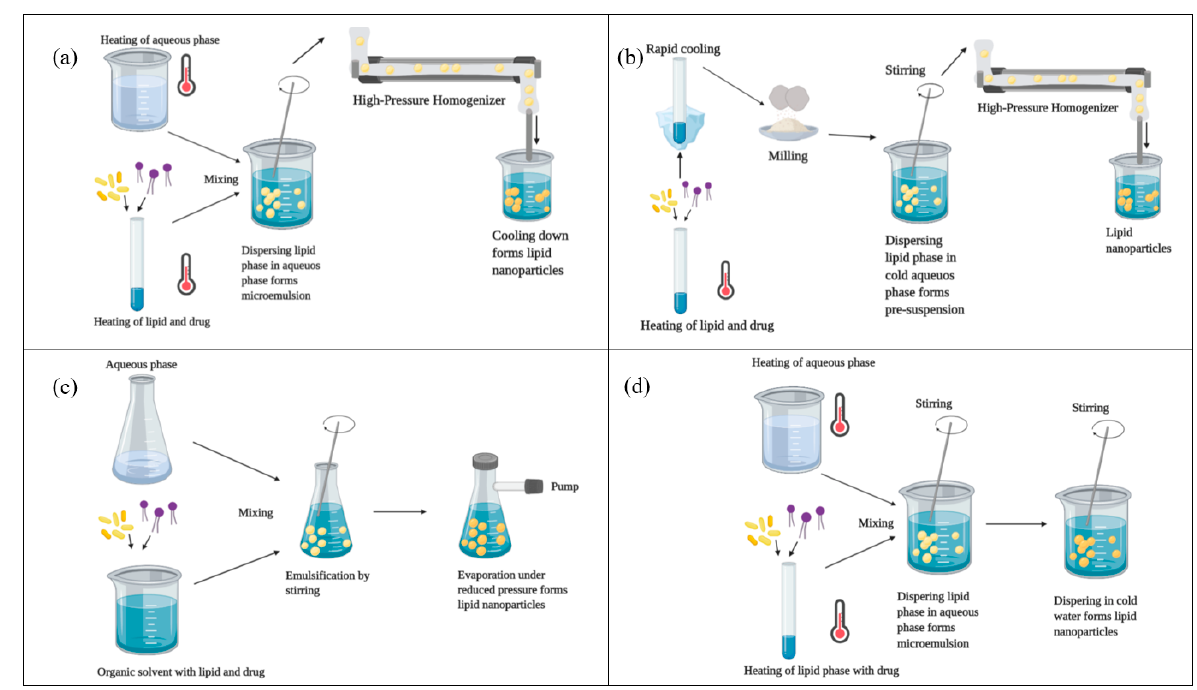
Figure 2. Visual representation of several conventional synthesis methods for LNP-based delivery systems. ( a ) hot high-pressure homogenization method; ( b ) cold high-pressure homogenization method; ( c ) solvent evaporation method; ( d ) microemulsion method. Adapted from [31], published by Uppsala University, 2020.